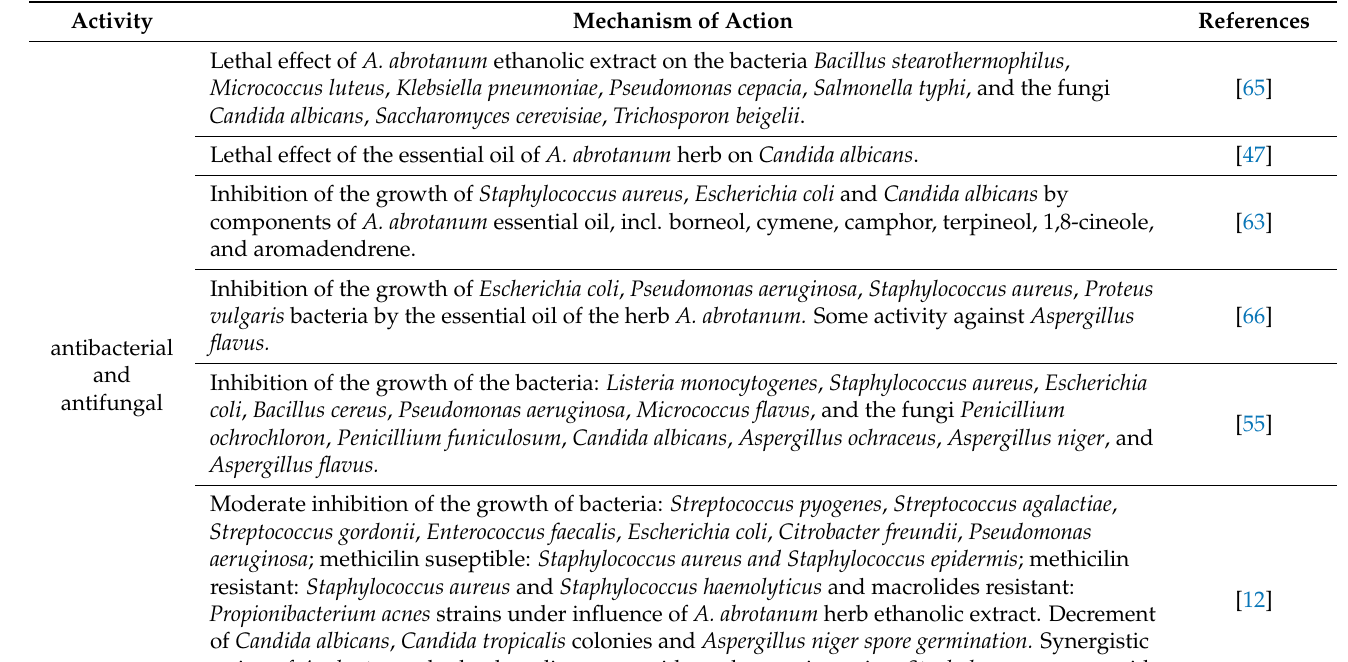
Table 3. Directions of biological activity of A. abrotanum confirmed by scientific